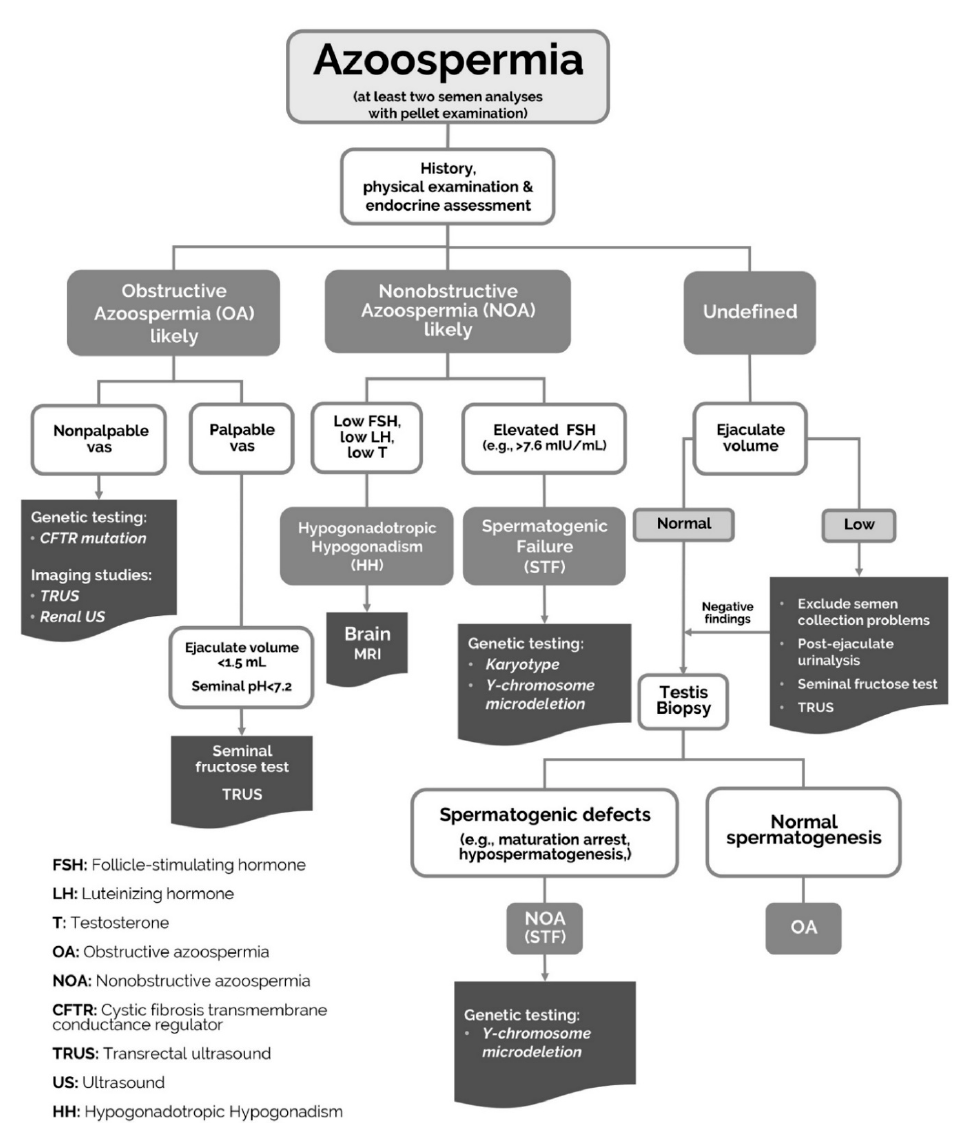
Figure 1. Algorithm for azoospermia differential